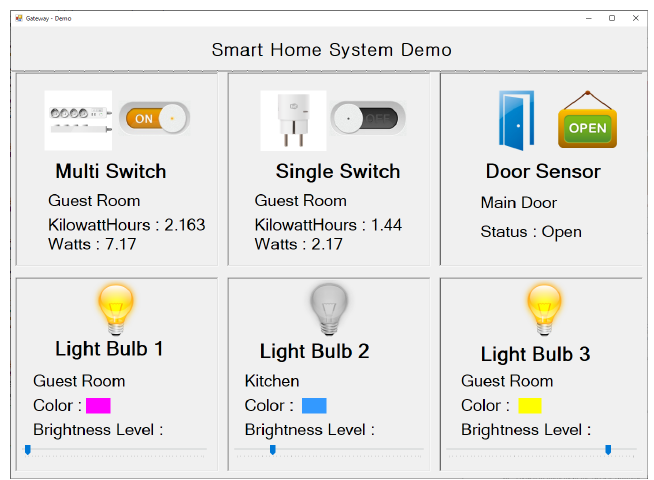
Figure 6. Smart home client (user) application on a